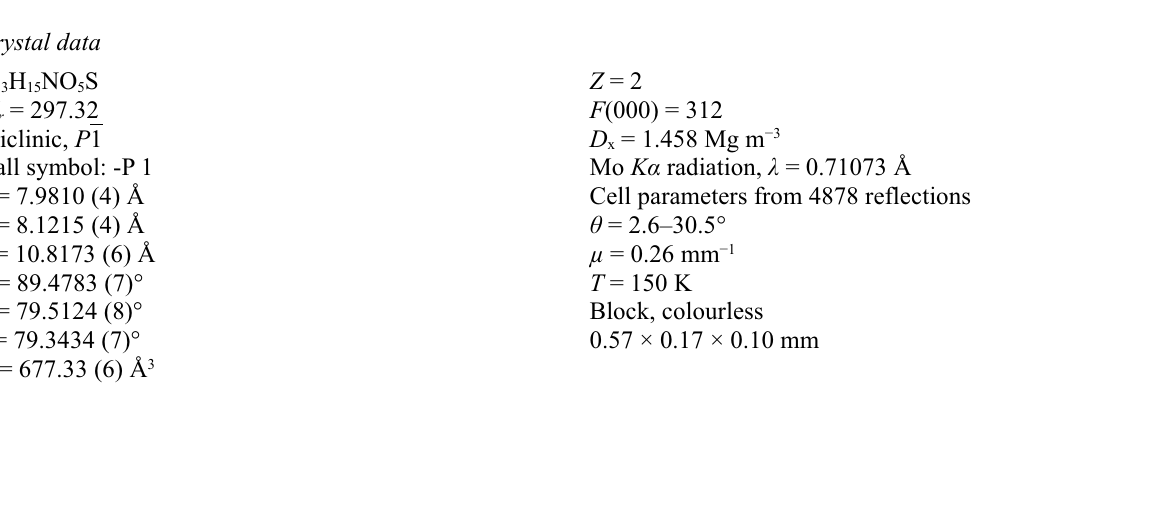
Packing plot showing the two unique weak H-bonds (thin dashed lines) and π - π interactions (thick dashed lines). Methyl 4-ethoxy-2-methyl-2 H -1,2-benzothiazine-3-carboxylate 1,1-dioxide Crystal